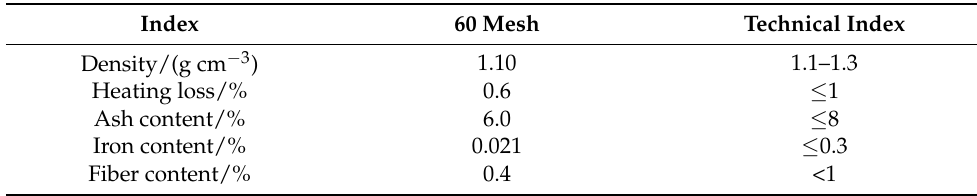
Figure 1. ( a ) LP-viscosity reducer additive; ( b ) SK-surfactant additive. Table 1. Physical properties of